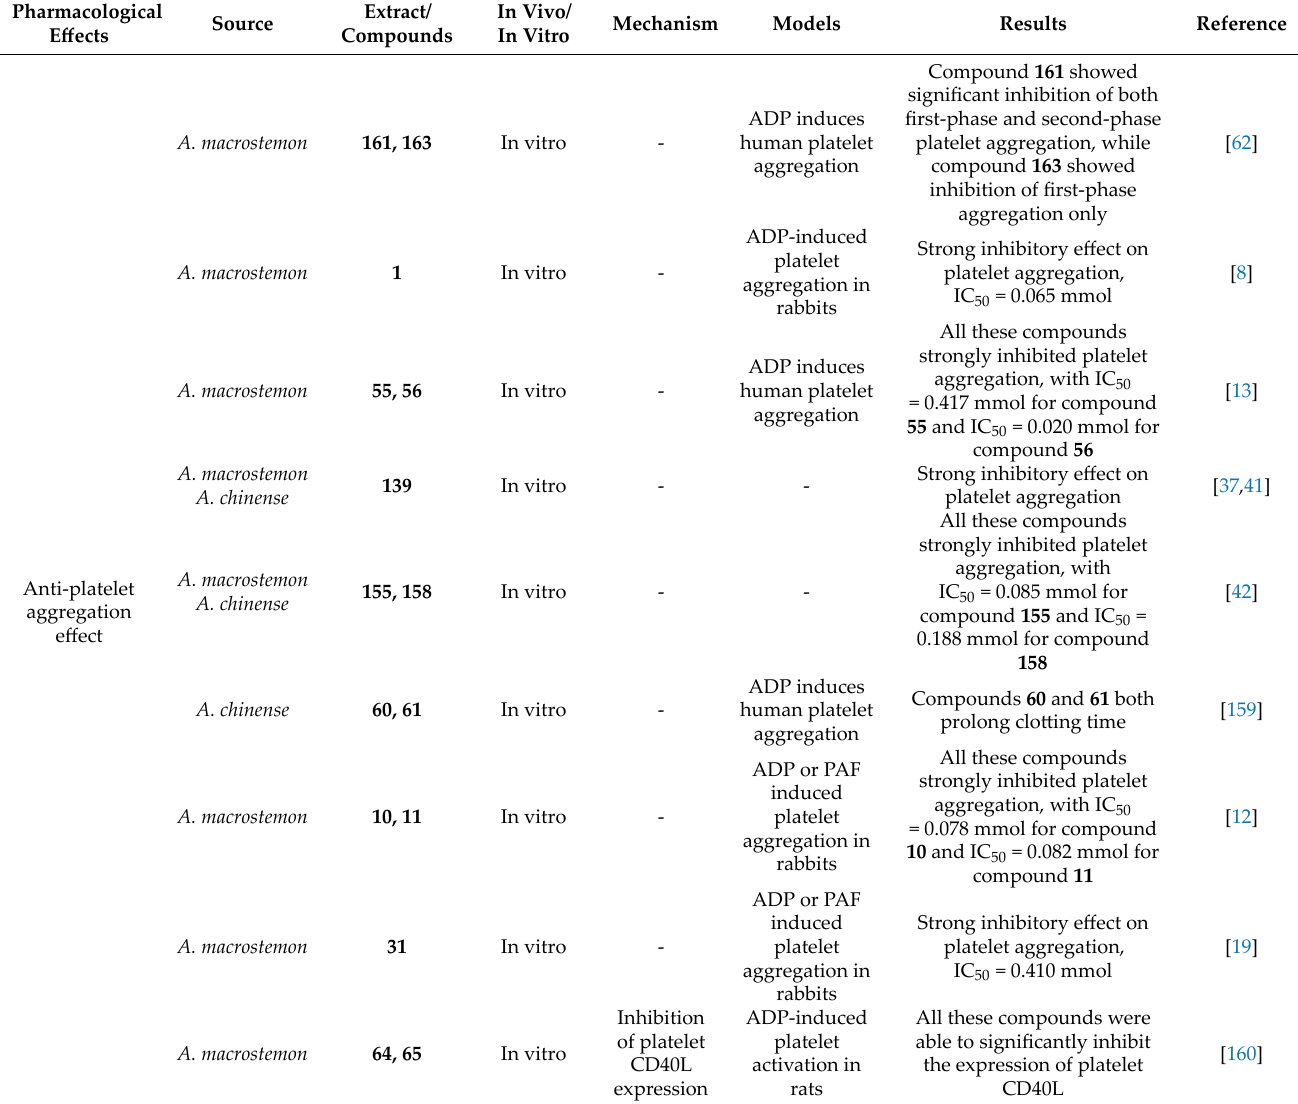
Table 9. Reported pharmacological activities of AMB extract or isolated